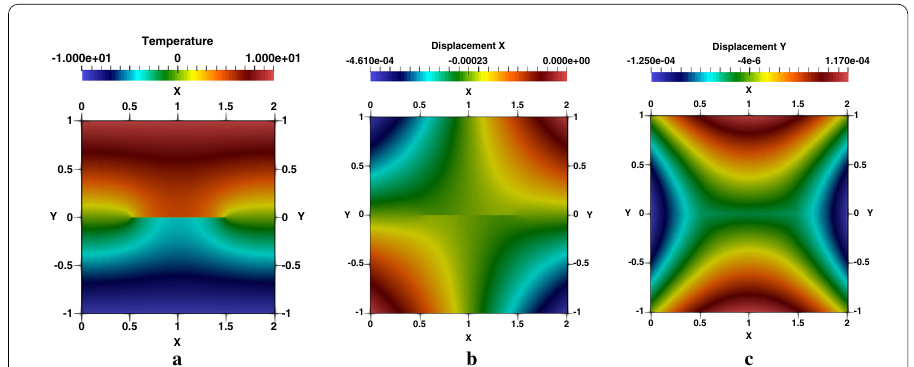
Fig. 5 Square plate with a centred crack, a / W = 0 . 5: a temperature, b e x -displacement and c e